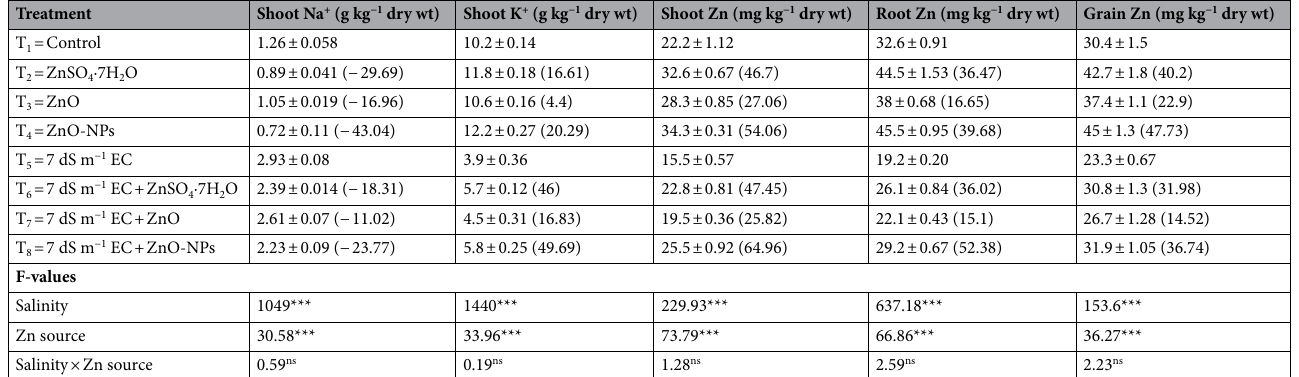
Table 6. Comparative effects of ZnO-NPs to other bulk Zn sources on salt tolerance attributes (g kg −1 dry wt) and Zn concentration (mg kg −1 dry wt) of rice. Values represent mean ± SE (n = 3). Values in parenthesis show percent increase or decrease from respective control. According to LSD test with multiple comparisons, F-values of the Two-way ANOVA are indicated as: ns not significant. *Significant at p ≤ 0.05. **Significant at p ≤ 0.01.